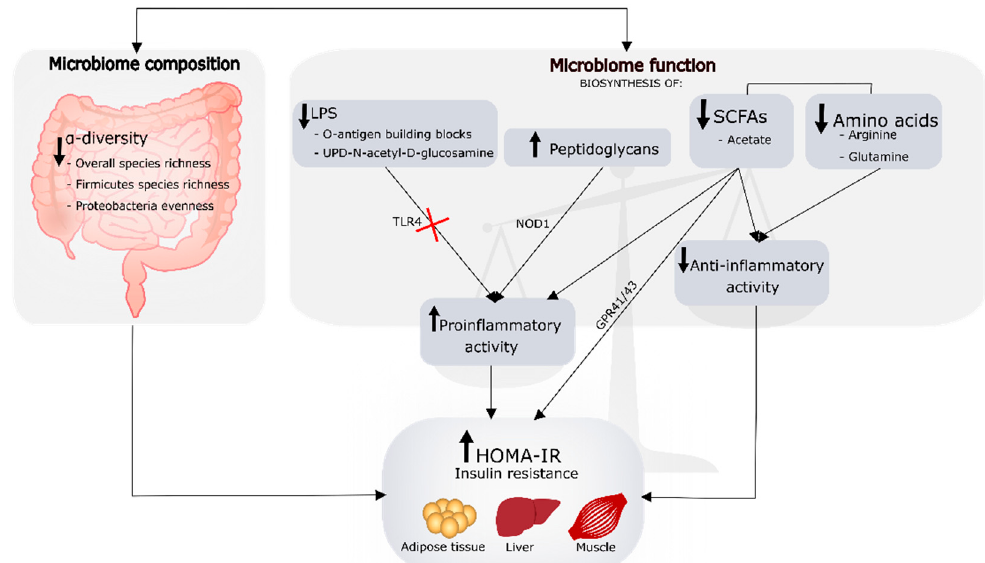
Figure 4. Graphical summary of the altered microbiome composition and functions associated with insulin resistance, determined by the homeostatic model assessment for insulin resistance (HOMA-IR) in the cohort study. Previous evidence has suggested a role of lipopolysaccharides (LPS) on the development of metabolic diseases. Here we found that other functional pathways might be contributing to a greater extent to insulin resistance through imbalances between proinflammatory and anti-inflammatory activities. These pathways are related to the biosynthesis of peptidoglycans, short-chain fatty acids (SCFAs), and amino acids. Potential mechanisms explaining these associations are briefly described in the figure. Abbreviations: TLR4, toll-like receptor 4; NOD1, nucleotide-binding oligomerization domain 1; GPR43, G-protein coupled receptors 43. Supplementary Materials: The following are available online at www.mdpi.com/xxx/s1, Supplementary methods; Table S1: Participants’ characteristics stratified by sex, Table S2: Correlations between the HOMA-IR and clinical characteristics, dietary intake, physical activity, and gut metabolites, Table S3: Partial correlations adjusted for age between HOMA-IR and α - diversity, species, and pathways, Table S4: Significant contributors of bacterial species β -diversity detected by canonical correspondence analysis, Figure S1: Relative abundance of phyla and species across HOMA-IR tertiles, Figure S2: Heat maps showing correlations of gut microbiota composition and function with CRP, Figure S3: Heat map showing correlations of gut microbiota composition and function with the homeostatic model assessment for insulin resistance, Figure S4: Abundance of CAZymes in children with obesity stratified by data-driven HOMA-IR tertiles.